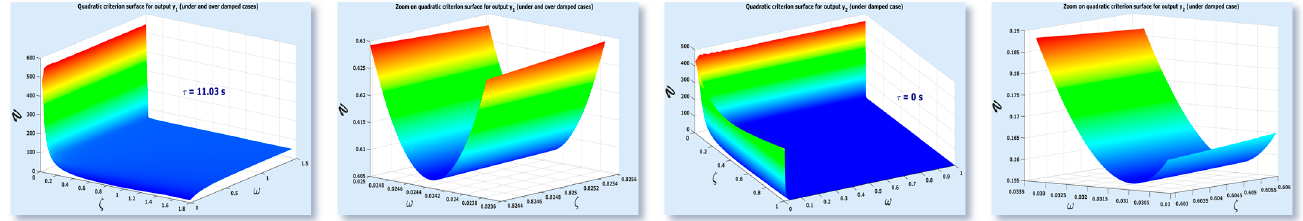
Figure A1. Quadratic criterion surfaces in identification of second order step response.